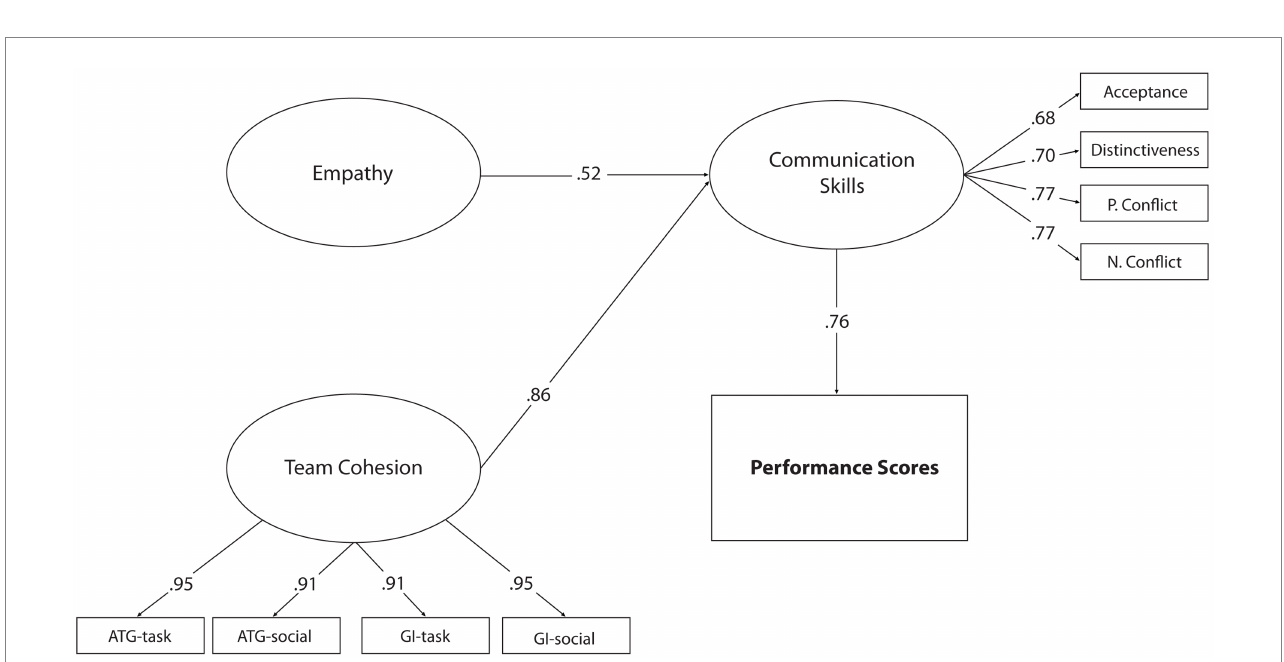
FIGURE 3 Standardized SEM results for Model